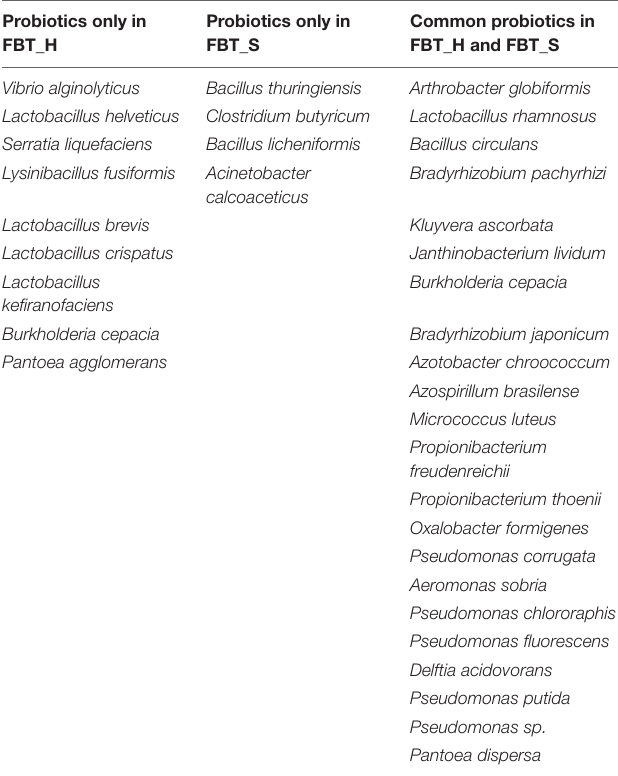
TABLE 1 | Probiotic composition between FBT_H and FBT_S based on probio database. Probiotics only in